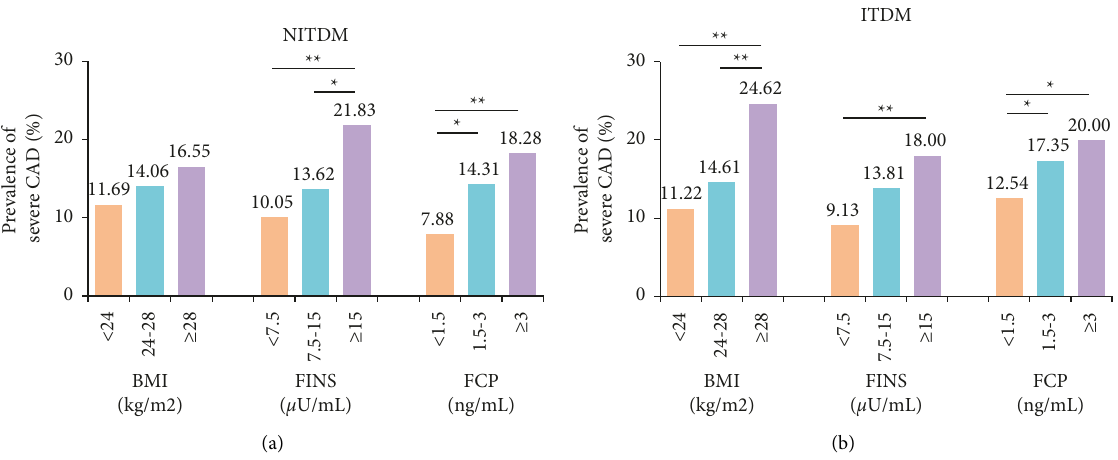
Figure 1: Prevalence of severe CAD in (a) NITDM and (b) ITDM patients according to BMI, FINS, and FCP. ∗ P < 0 . 05 and ∗∗ P < 0 . 01. BMI, body mass index; CAD, coronary artery disease; FCP, fasting C peptide; FINS, fasting insulin; ITDM, insulin-treated diabetes mellitus; NITDM, non-insulin-treated diabetes increased risk of severe CAD in the ITDM group ( P < 0 . 001), Table 1, were analyzed in the logistic regression model. The rather than FINS and FCP (Table 2). correlation among age, hypertension, and severe CAD was statistically significant in both subgroups. The duration of diabetes did not correlate with severe CAD in both groups. FCP, instead of BMI, were positively associated with in- creased risk of severe CAD in the NITDM group ( P � 0 . 038). On the contrary, BMI was associated with